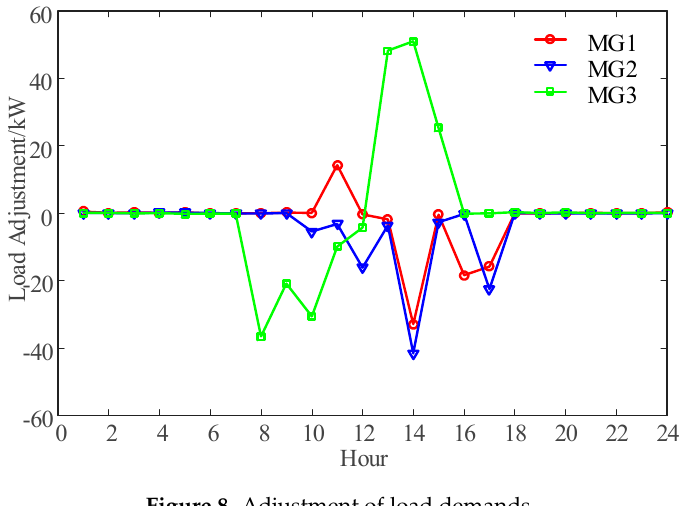
Figure 7. Impact of ESS scheduling on the benefits of MGs.